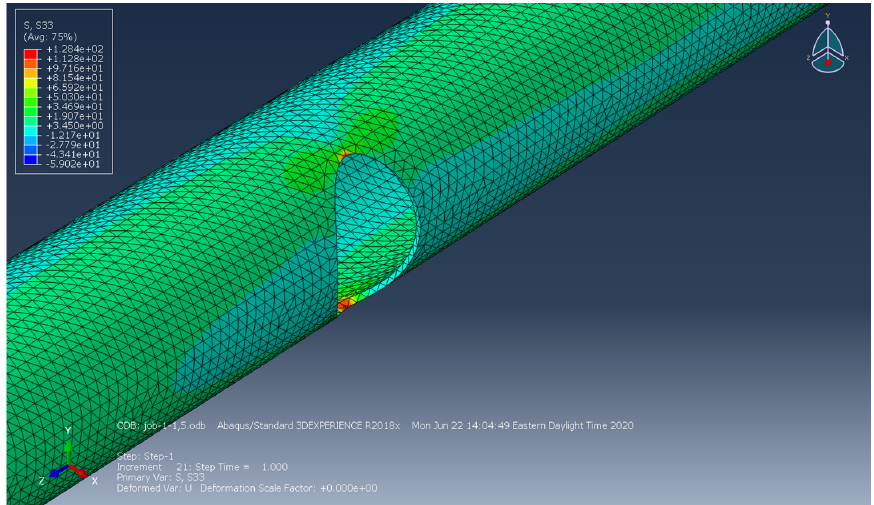
Figure 16. Aspect ratio 1-1.5 in longitudinal (Z) direction.